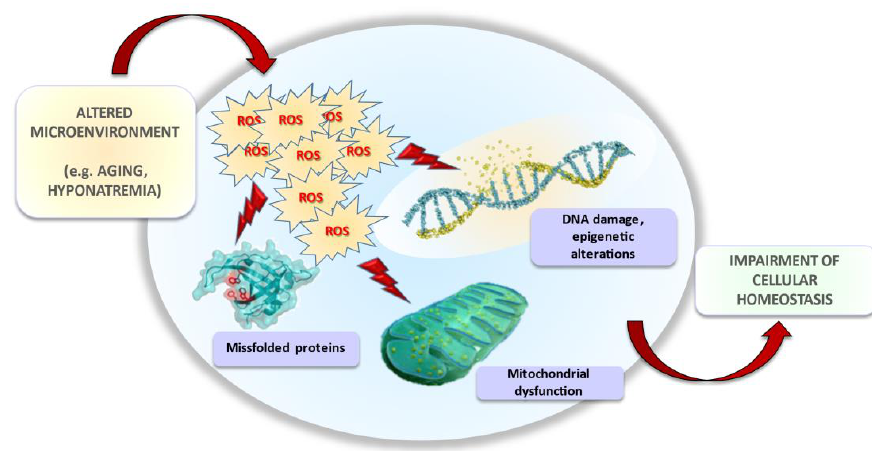
Figure 4. Effects of hyponatremia on cell and tissue homeostasis.